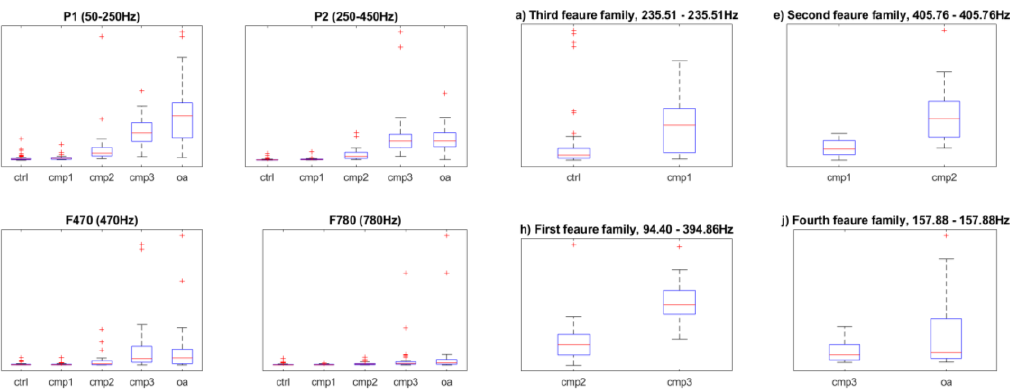
Figure 8. Boxplots of the features defined in [1] compared to boxplots of the new features defined for neighboring classes. The letters in titles of the new features correspond with Tables 1 and 2.